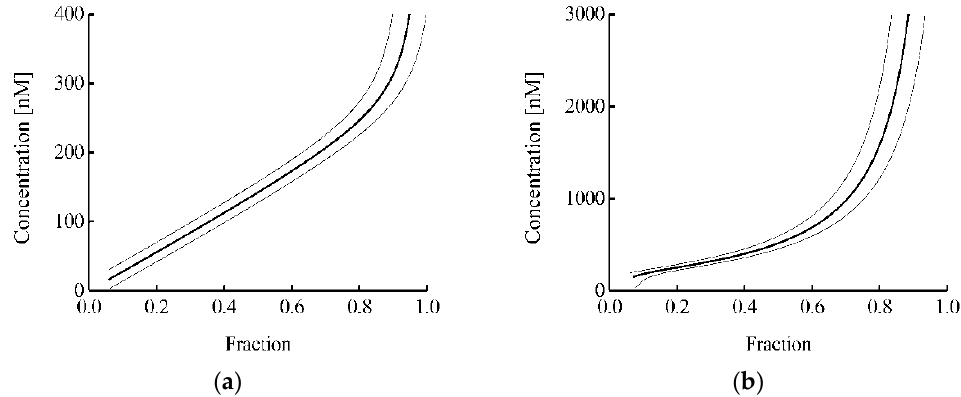
Figure 5. Dependences of the fmKeap1 protein concentration on the fraction of Keap1 bound to this protein ( a ) and free Nrf2 ( b ). Thin lines mark the range of standard errors.